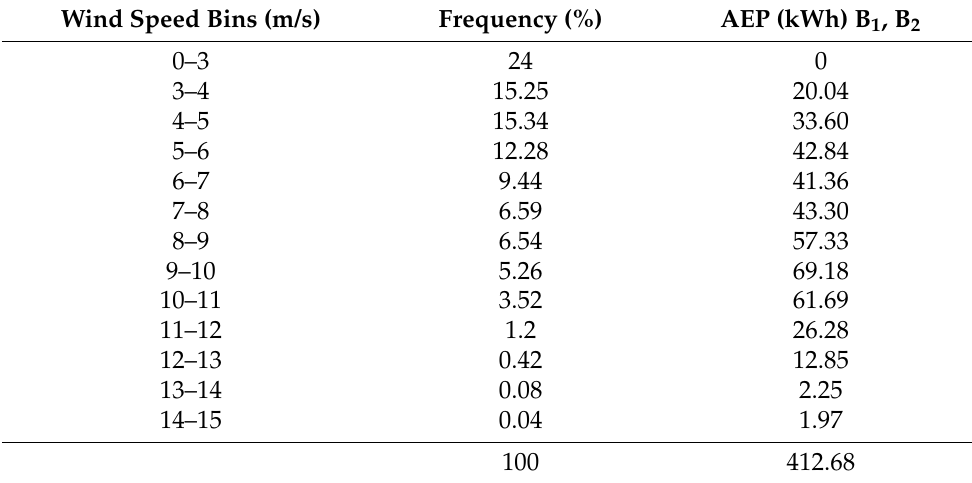
Table 9. AEP of a single wind turbine for individual wind speed bins (free-standing typology). Wind Speed Bins